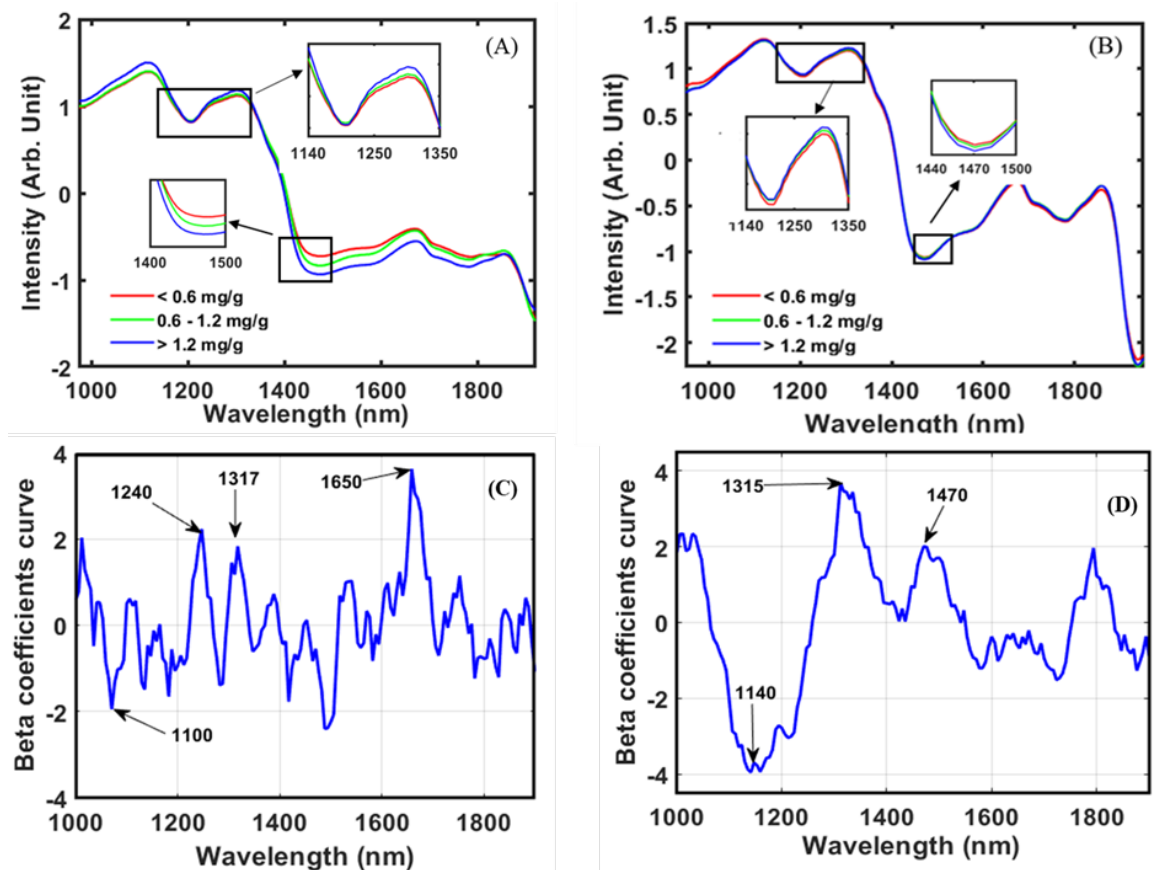
Figure 3. Mean of near-infrared pre-processed spectra using SNV of three rice group based on the anthocyanins content for seed sample ( A ) and powder sample ( B ), and beta coefficients curve of PLSR model for seed ( C ) and powder ( D ).